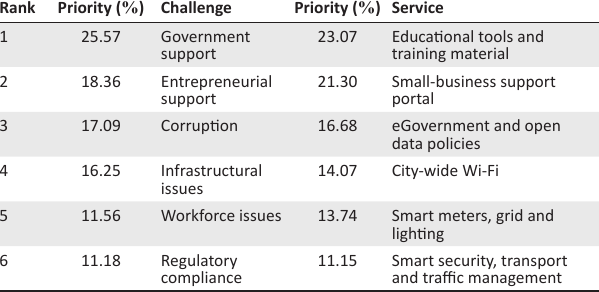
TABLE 3: Weighted rankings of small-business challenges and smart city services. Rank Priority ( % )